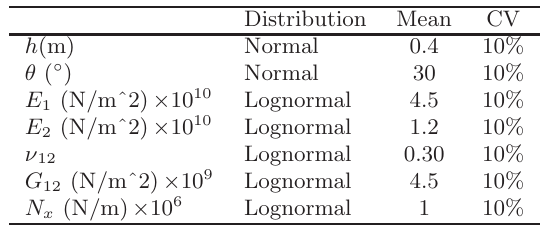
Table 4. Statistical parameters of design variables of the lam- inated composite plate, case